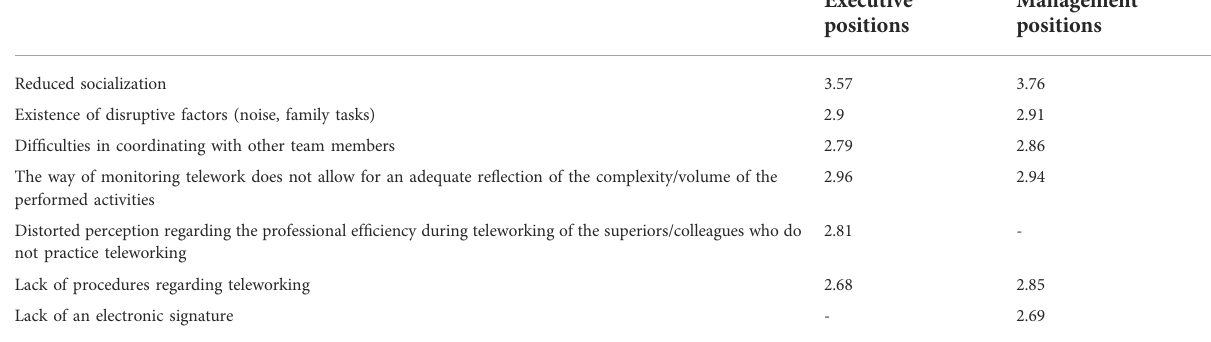
TABLE 4 Individual disadvantages related to teleworking (medium